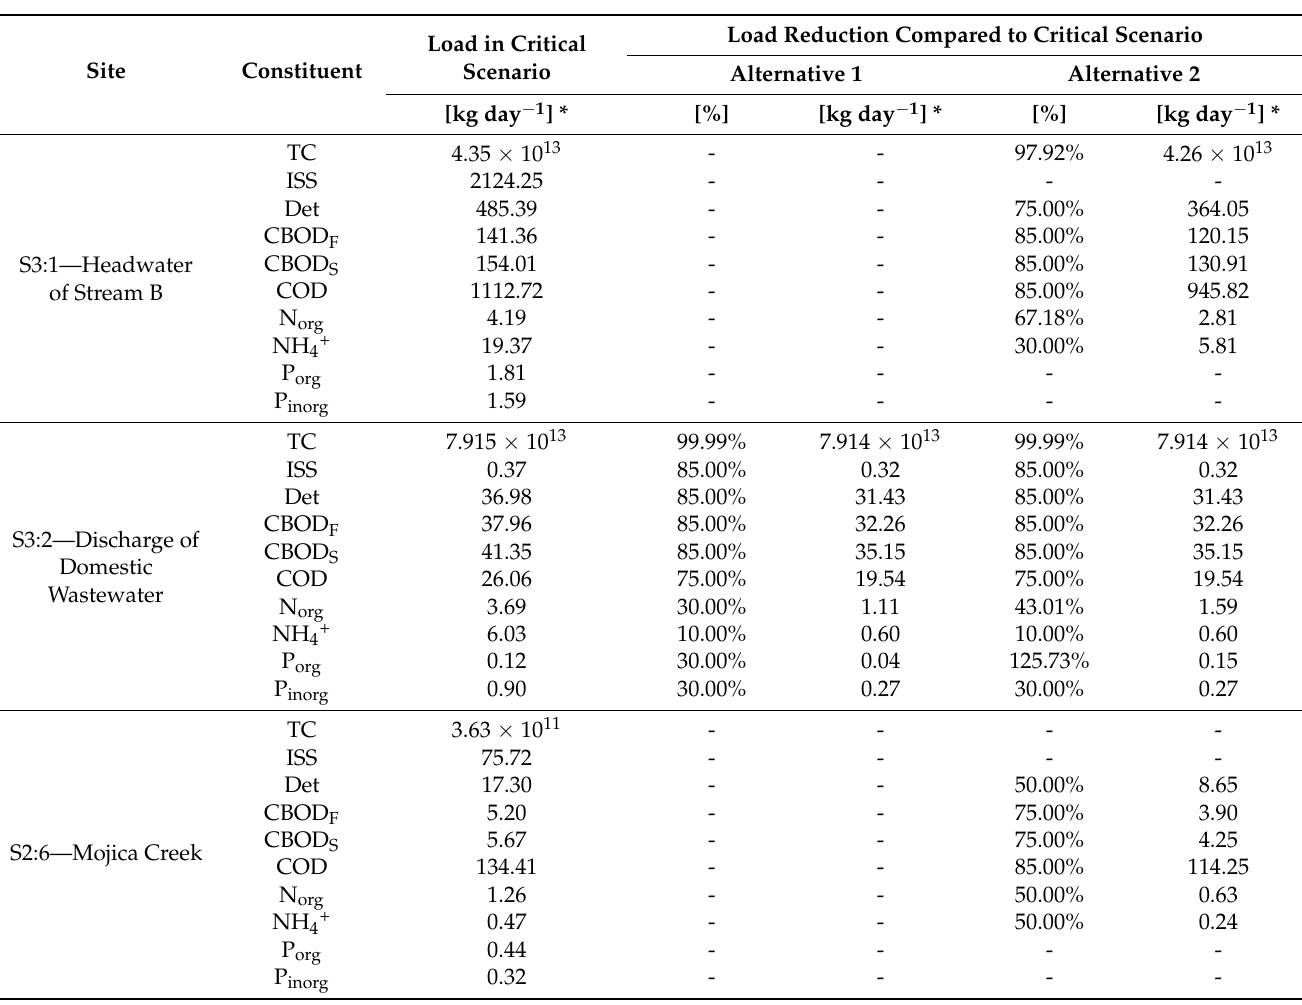
Table 9. Description of alternative scenarios in the case study.